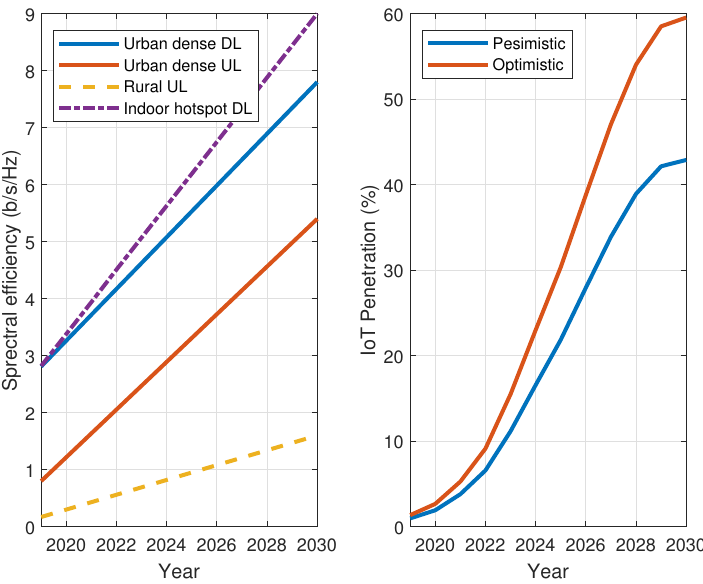
Figure 2. Left : Ideal spectral efficiency increase in a 10-year period. Right : Optimistic and pessimistic 10-year forecast for IoT penetration